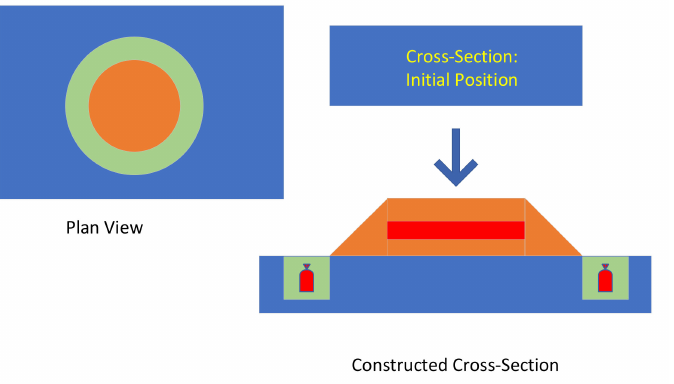
Figure 23. Raised Field Irrigation Scheme. A raised mound is created (brown), surrounded by a ditch (green). ZVI desalination pellet placement locations are shown in red.